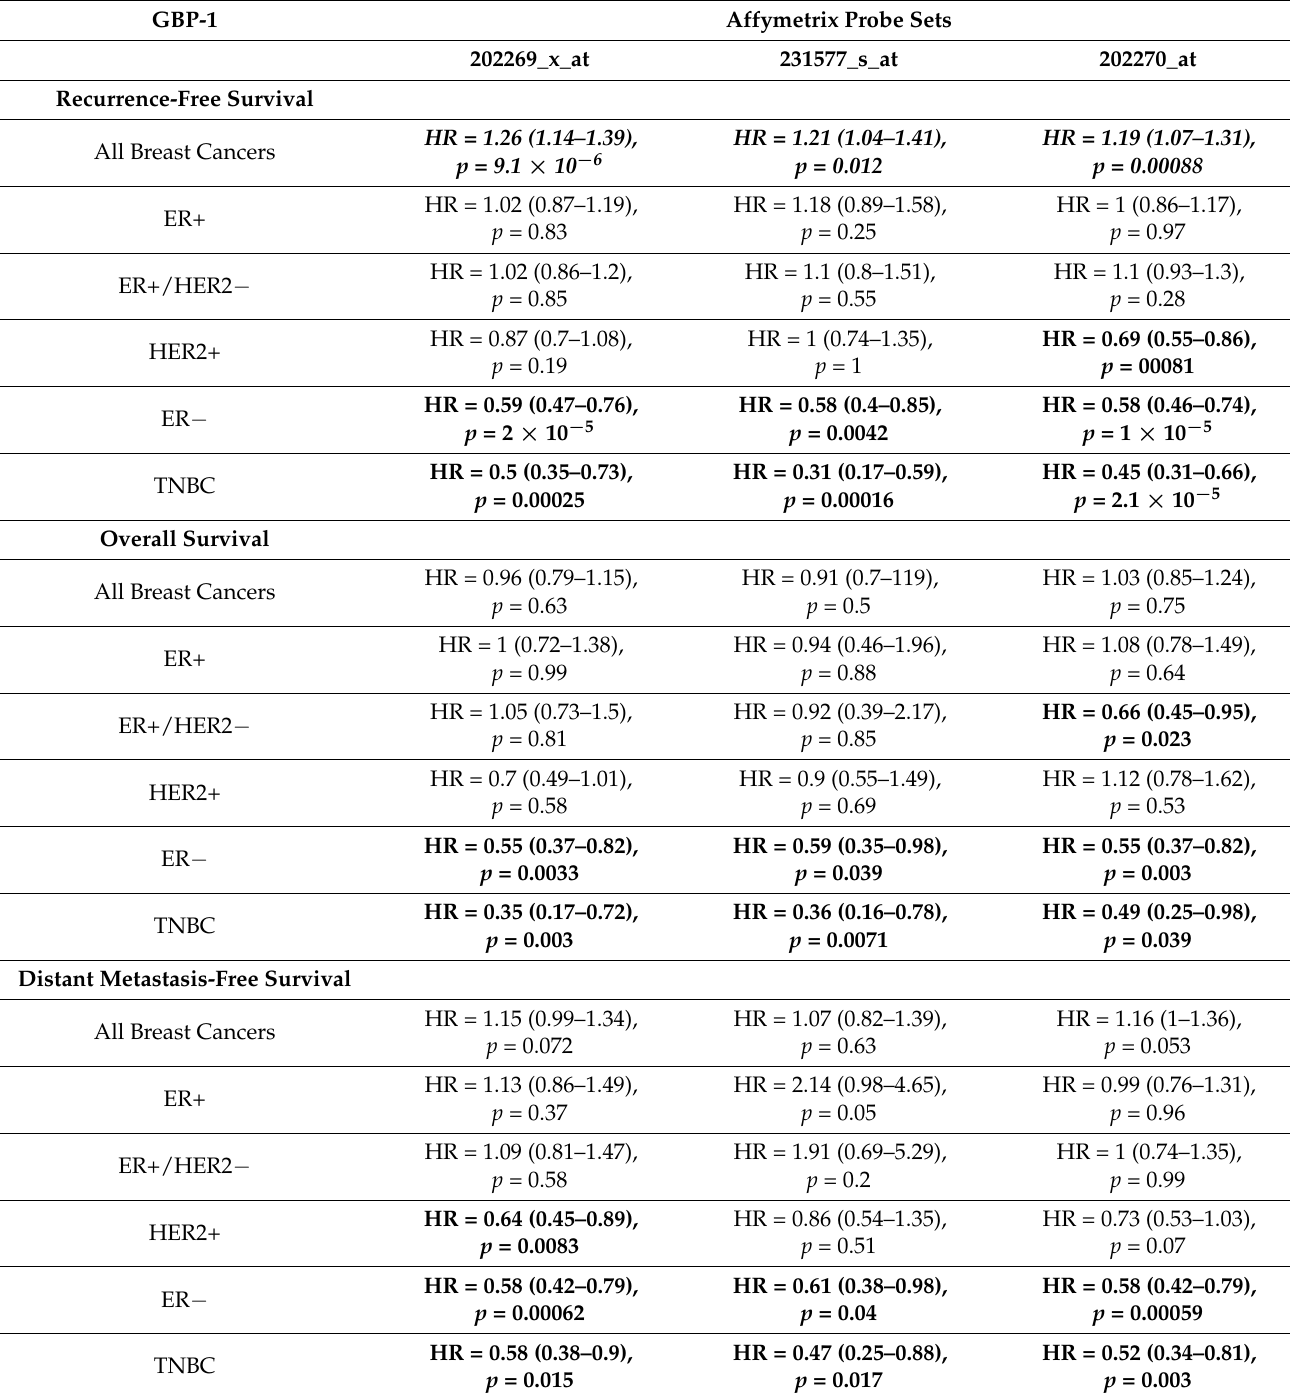
Table 4. Data from all three GBP-1 probe sets of the HG-U133A Affymetrix microarray were analyzed for Recurrence-Free Survival (RFS), Overall Survival (OS), and Distant Metastasis-Free Survival (DMSF) using KmPlotter. The data are presented as Hazard Ratio (HR) immediately followed by the HR number. The range of numbers within the paratheses is the 95% confidence interval. p represents the LogRank p . Bold values are those that indicate that higher expression of GBP-1 significantly improves that outcome. Data that are both in bold font and in italics describe a situation where elevated GBP-1 is significantly correlated with poorer